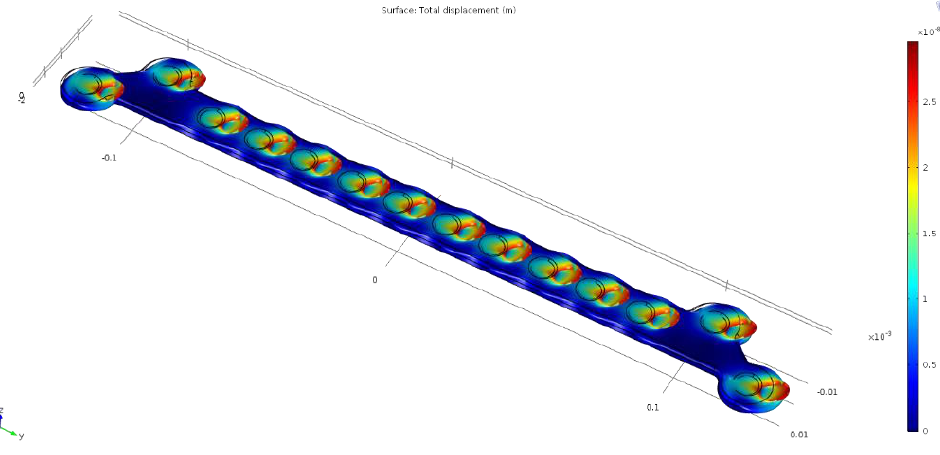
Figure 9. Total displacement of newly developed plate.